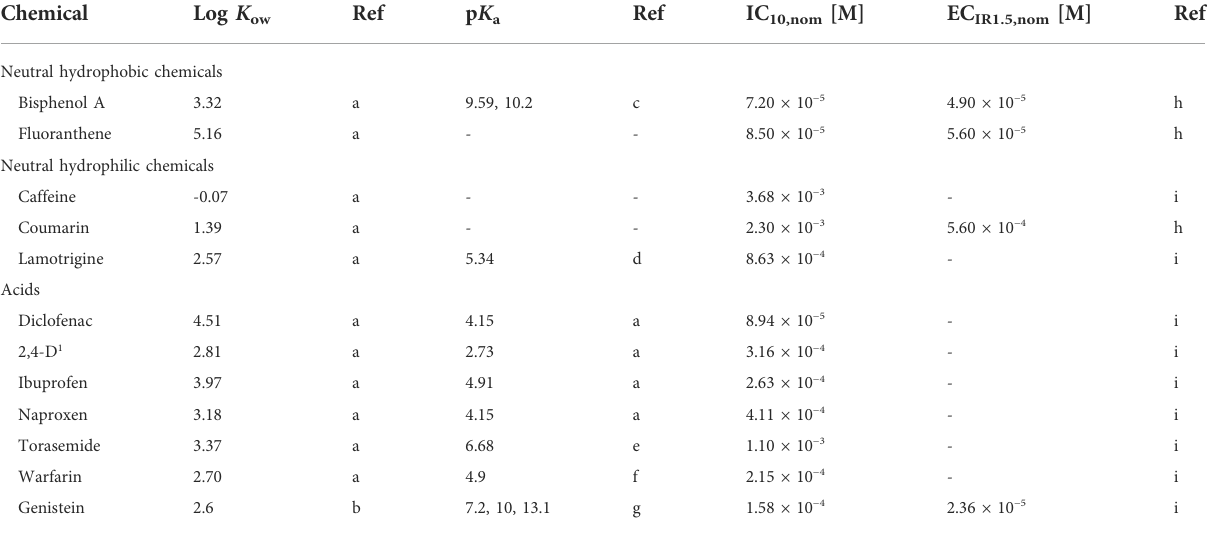
TABLE1Testchemicalswiththeirrespectivechemicalclass,logarithmicoctanol-waterpartitionconstants(log K ow ),acidityconstants(p K a ),reported nominal concentrations causing 10% inhibition of cell viability (IC 10,nom ) and 1.5-fold induction of oxidative stress response (EC IR1.5,nom ) in the AREc32